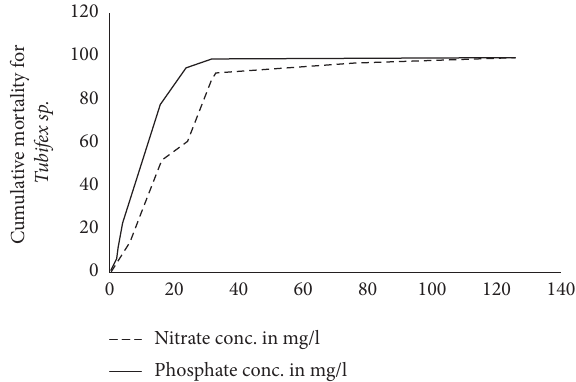
Figure 3: 96-hour concentration response curves showing cu- mulative mortality for T.